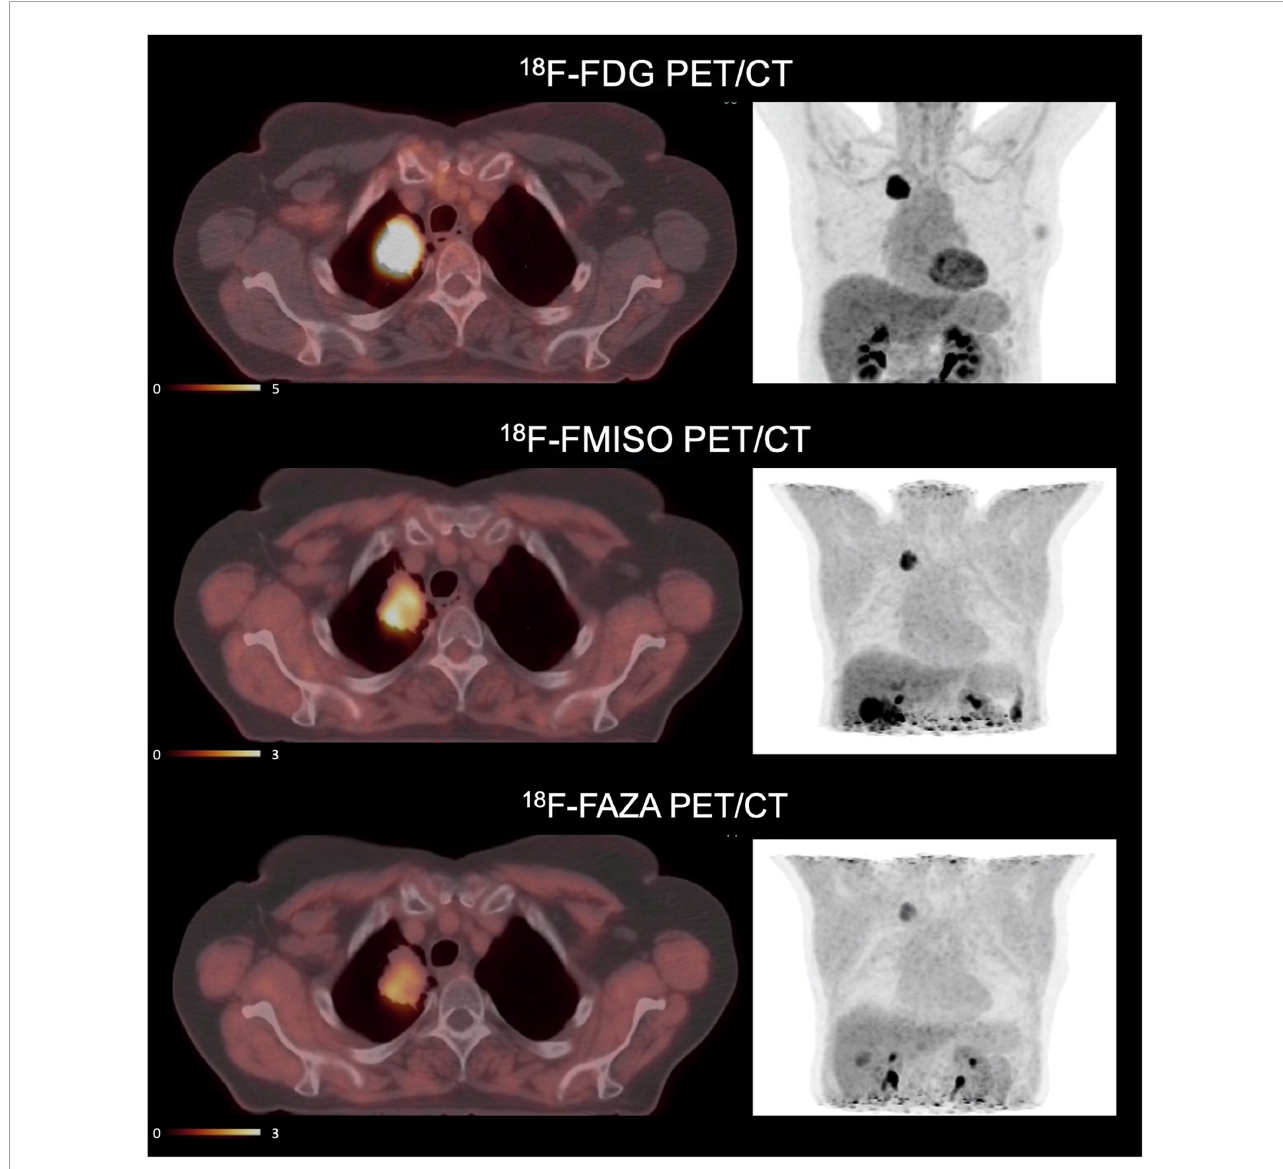
FIGURE3 Example of PET imaging of a patient with [ 18 F]-FDG, [ 18 F]-FMISO and [ 18 F]-FAZA. This patient with non-small cell lung cancer is included in a clinical trial “RTEP6” and signed an informed consent. Hypermetabolic regions are visualized by [ 18 F]-FDG and hypoxic regions by [ 18 F]-FMISO and [ 18 F]-FAZA. Standardized uptake values (SUV) of [ 18 F]-FDG are of an order of magnitude 5 times higher than SUV of [ 18 F]-FMISO and [ 18 F]-FAZA. The accumulation of tracers does not necessarily occur in the same tissue territories. The uptake of [ 18 F]-FAZA is lower than [ 18 F]-FMISO